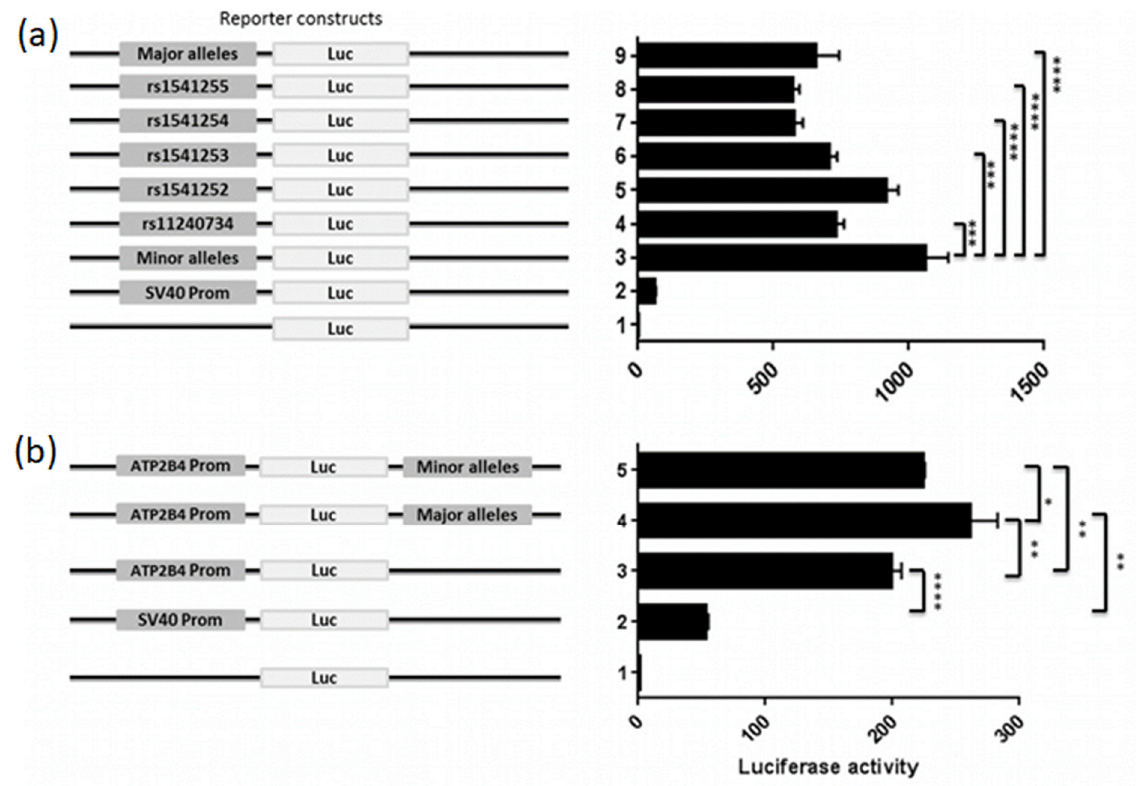
Figure 6. Luciferase reporter assay accessing the promoter and enhancer activity of ATP2B4 variants in K562 cells. ( a ) Promoter activity of the DNA region containing ATP2B4 Major and Minor haplotypes in addition to individual polymorphism. ( b ) Enhancer activity of ATP2B4 SNPs with Major and Minor haplotypes. SV40 promoter and basic vectors were used as positive and negative controls, respectively. Data presented as the mean ± standard deviation of three independent experi- ments. **** p < 0.0001, *** p < 0.001, ** p < 0.01, * p < 0.05.